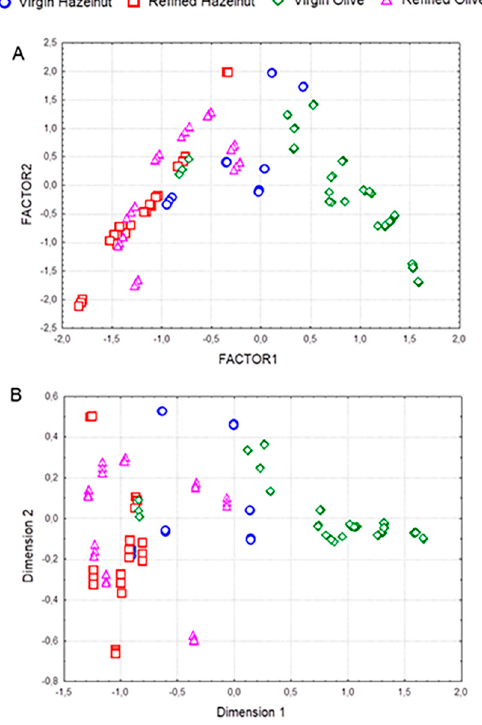
Figure 2. Principal component analysis (PCA) score plot ( A ) and multidimensional scaling plot ( B ) showing the distribution of samples from the four study groups in the plane defined by the two first principal components.